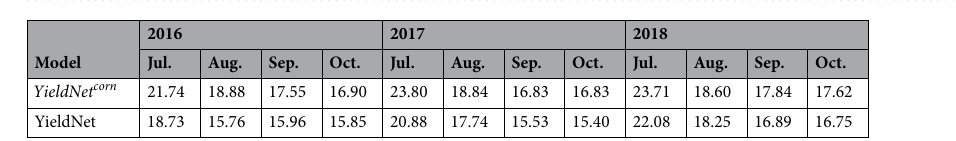
Figure 8. The scatter plots for the 2018 soybean yield prediction during the growing season in months July, August, September, and October. MAE and r stand for mean absolute error and correlation coefficient, respectively. The unit of yield is bushels per acre.